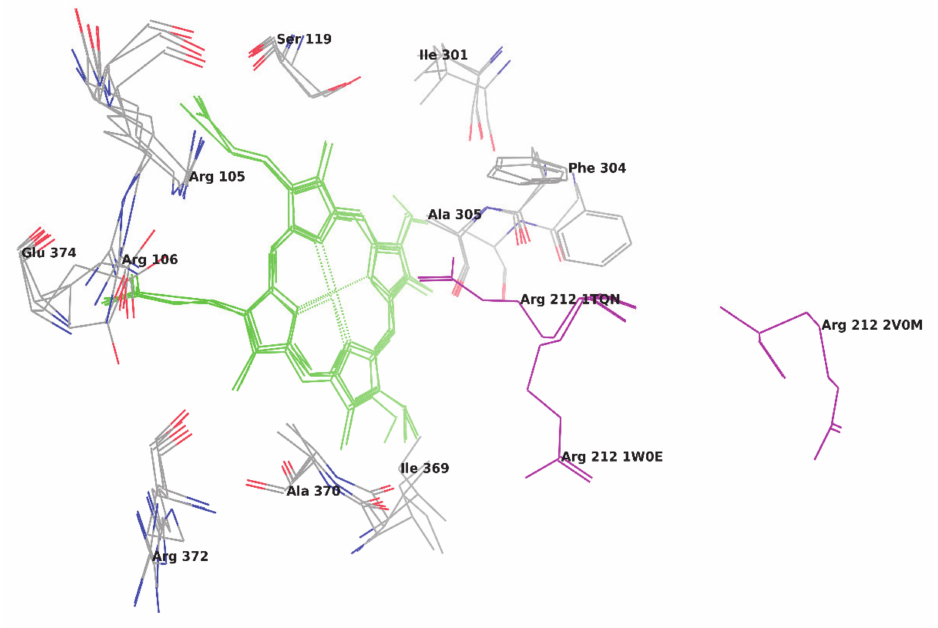
Figure 1. Superimposition of three crystal structures of